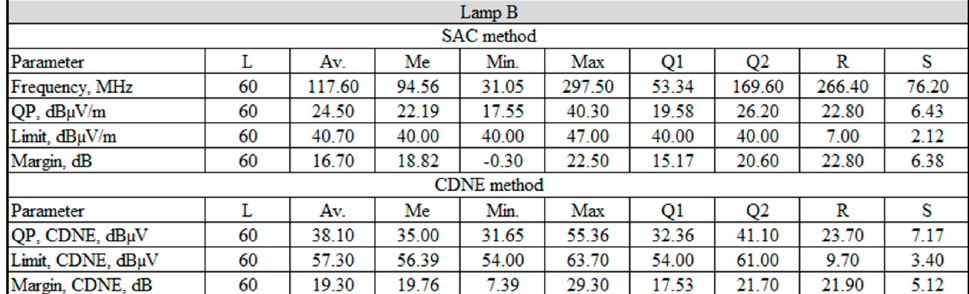
Figure 10. Recorded QP values using the new and traditional method against the allowable limits for the LED lamp B under test, where: L—number of analysed values; AV—calculated average value; Min, Max—minimum and maximum values; Q1, Me(Q2), Q3—first, second and third quar- tile; R—range; and S—standard deviation.